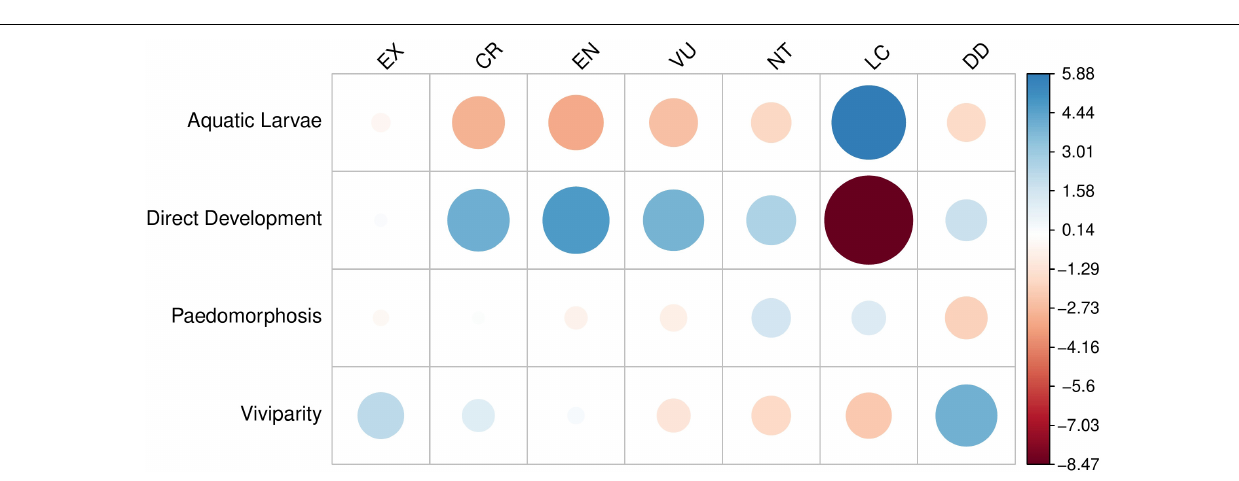
FIGURE 5 | Disparities in conservation status of amphibian life-history strategies ( χ 2 = 242.64, df = 18, p -value < 2.2e–16). Size and color of points are scaled to Pearson’s residuals. Warm colors indicate groups with fewer species expected by chance; cool colors indicate groups with more species than